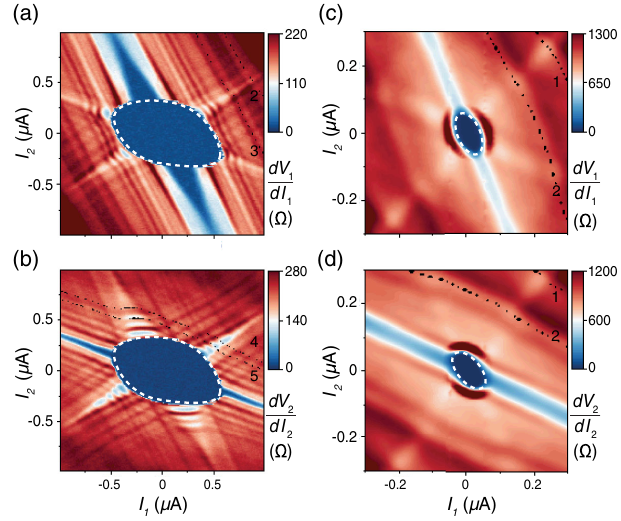
FIG. 2. Transport in three-terminal junctions. (a),(b) Differ- ential resistance maps of the device shown in Fig. 1(b); terminal 3 is grounded. (c),(d) Same measurement for the device shown in Fig. 1(c). The CCC of both junctions are indicated by a dashed white line as a guide for the eye. The radial features in the resistance corresponding to the three conditions V 1 ¼ 0 , V 2 ¼ 0 , and V 1 − V 2 ¼ 0 . Some of the MAR conditions eV 1 ¼ 2 Δ =n (a),(c) and eV 2 ¼ 2 Δ =n (b),(d) are shown as the black lines obtained using independently measured voltages V 1 and V 2 ( n ¼ 1 ; 2 ; … ; 5 ). The third set of MAR corresponding to e ð V 1 − V 2 Þ ¼ 2 Δ =n is not marked. The induced gap Δ is about 180 μ eV for both